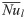
Effect of Ra and α on Nu¯l for the two selected porous matrixes in the case A = 1 (square cavity).